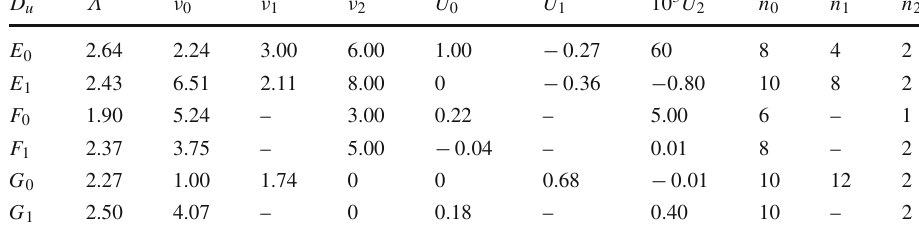
Table 8 Parameters of the BSA representation in Eq. (67) for the D